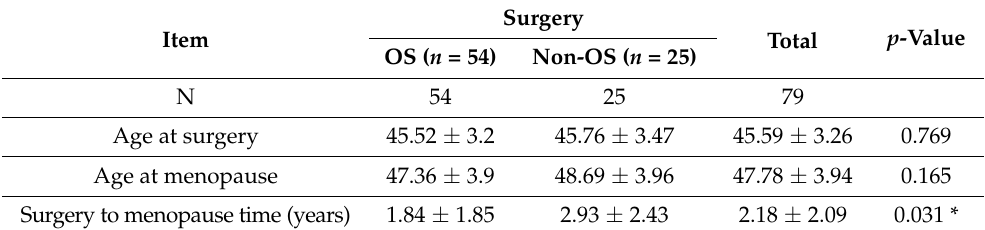
Table 3. Postoperative onset time of menopause.